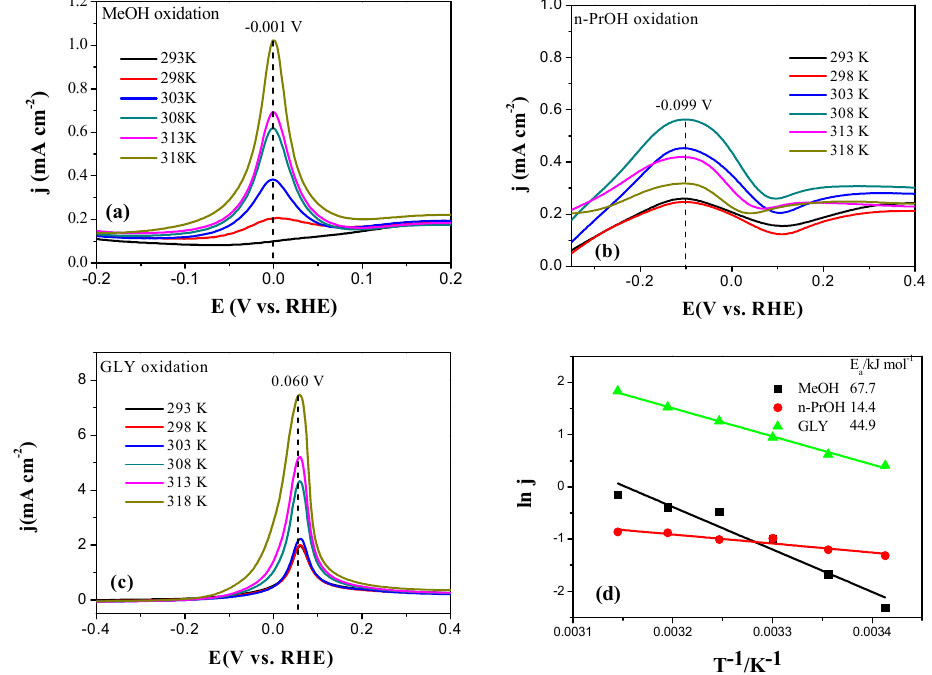
Figure 13. ( a – c ) LSVs of Pd electrode in 0.1 M KOH + 0.025 M alcohol; ( d ) Arrhenius plot of alcohol eletro-oxidation on Pd at peak potentials.